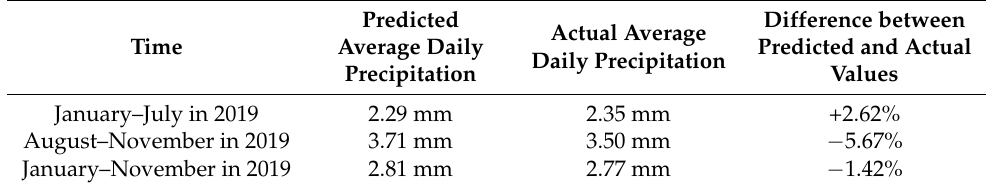
Table 6. Comparison of predicted and actual daily precipitation for